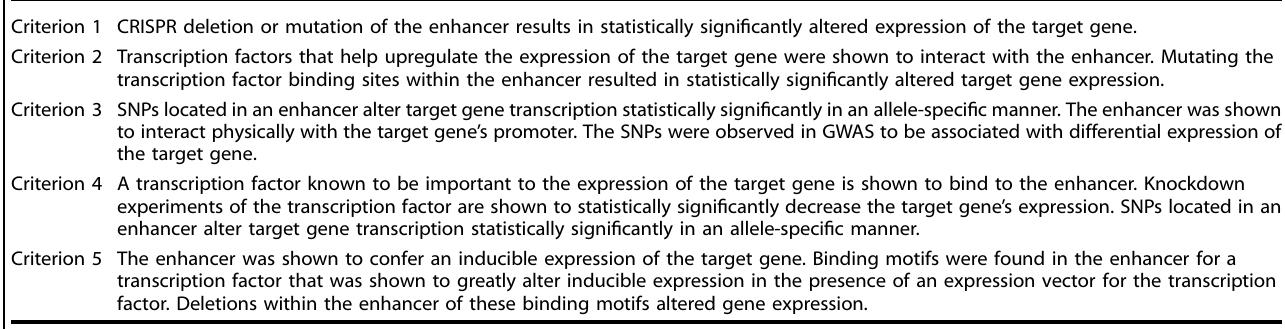
Table 1. Description of the positive set